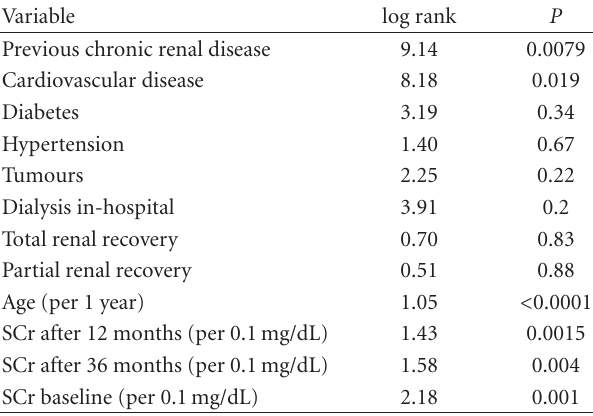
Table 3: Univariate analysis of risk factors associated with late mortality of patients after an episode of acute tubular